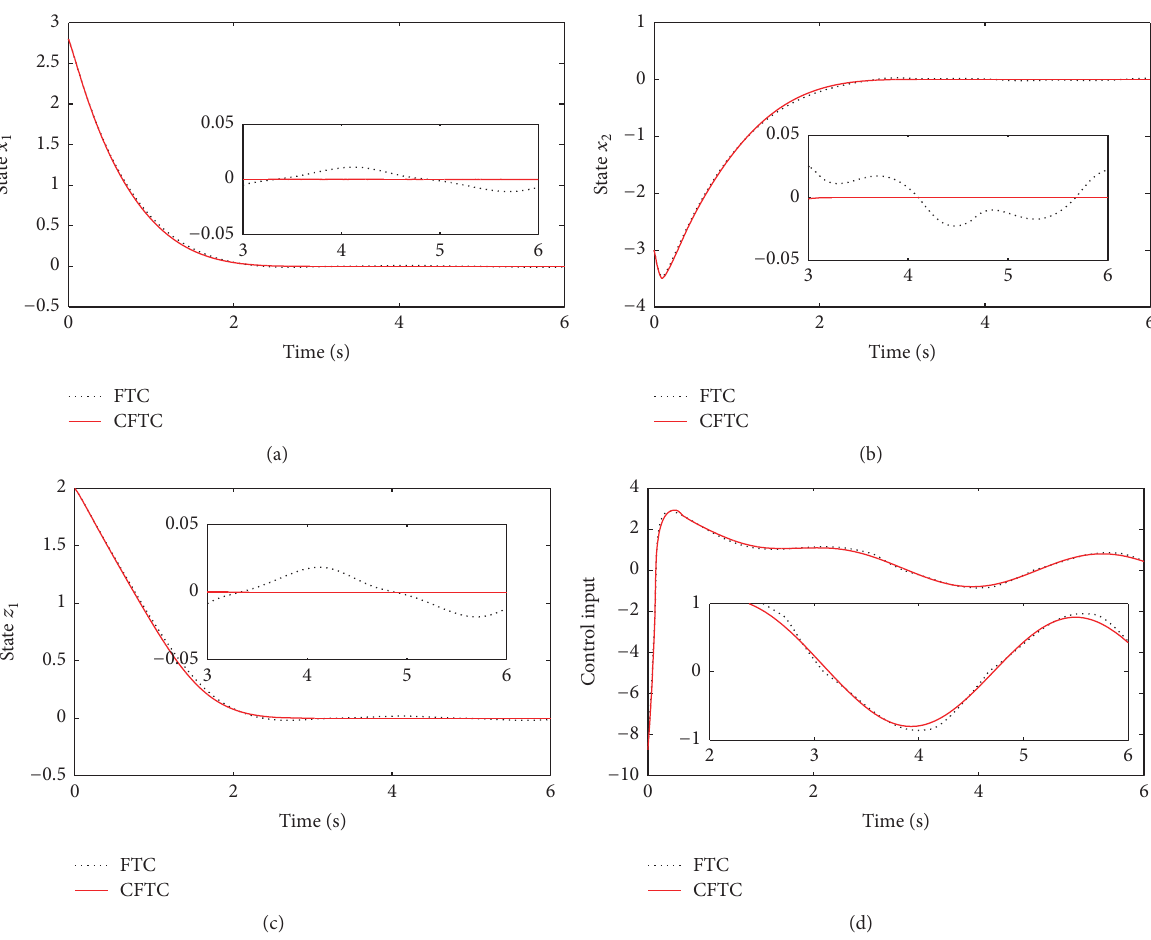
Figure 3: The response curves of system (43) under two different control FTC (44) (dotted line) and CFTC (45) (solid line). (a) State 𝑥 1 , (b) state 𝑥 2 , (c) state 𝑧 1 , and (d) control input.